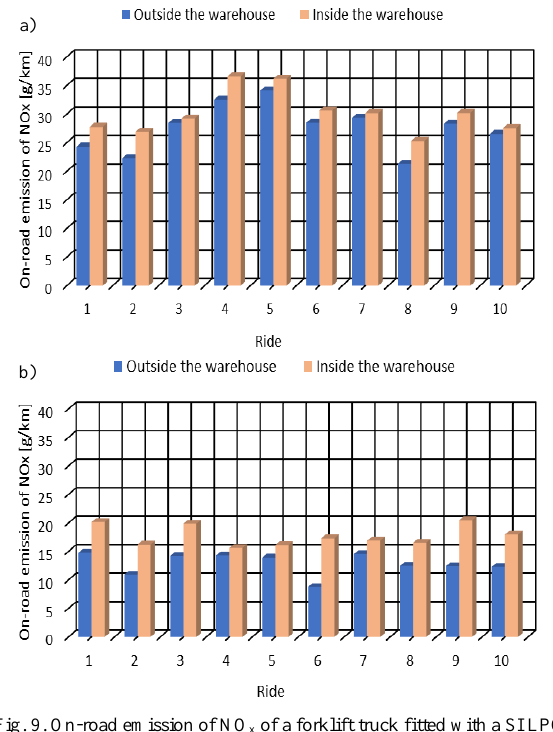
Fig. 9. On-road emission of NO x of a forklift truck fitted with a SI LPG engine: a) when carrying a load b) when driving unloaded